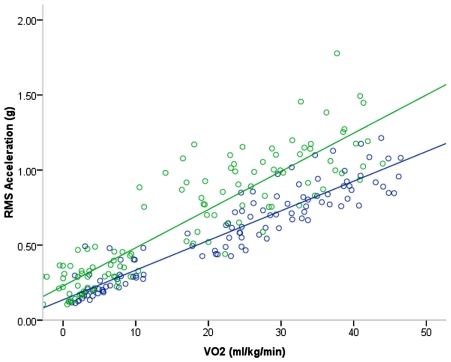
Regressions of VO2 versus RESrms acceleration during walking and running in highly trained (T) and untrained (UT) runners.Green points – UT individual values. Green line – UT regression (r = 0.92; p<.001). Blue points – T individual values. Blue line – T regression (r = 0.96; p<.001).